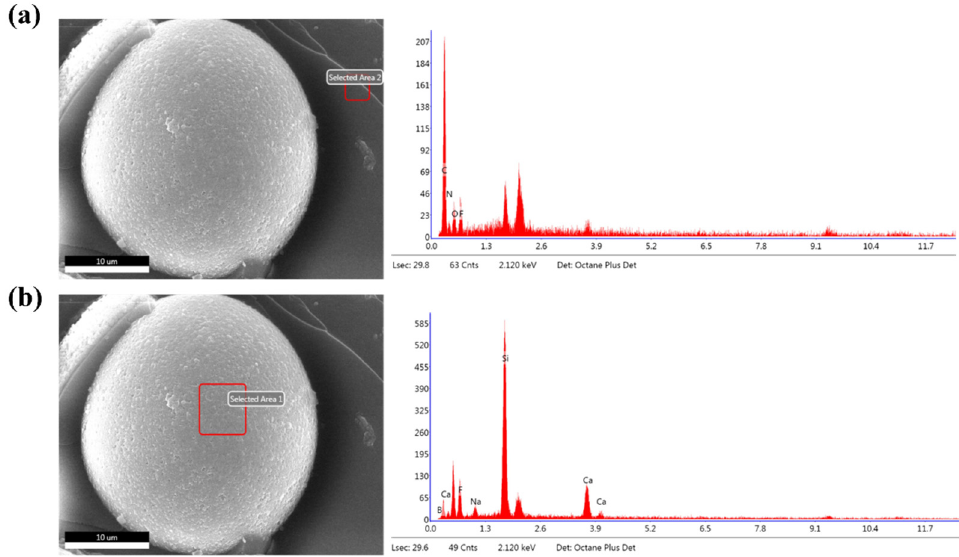
Figure 5. EDS point scanning in composite: ( a ) PBDP resin, ( b ) HGM-NH 2 .